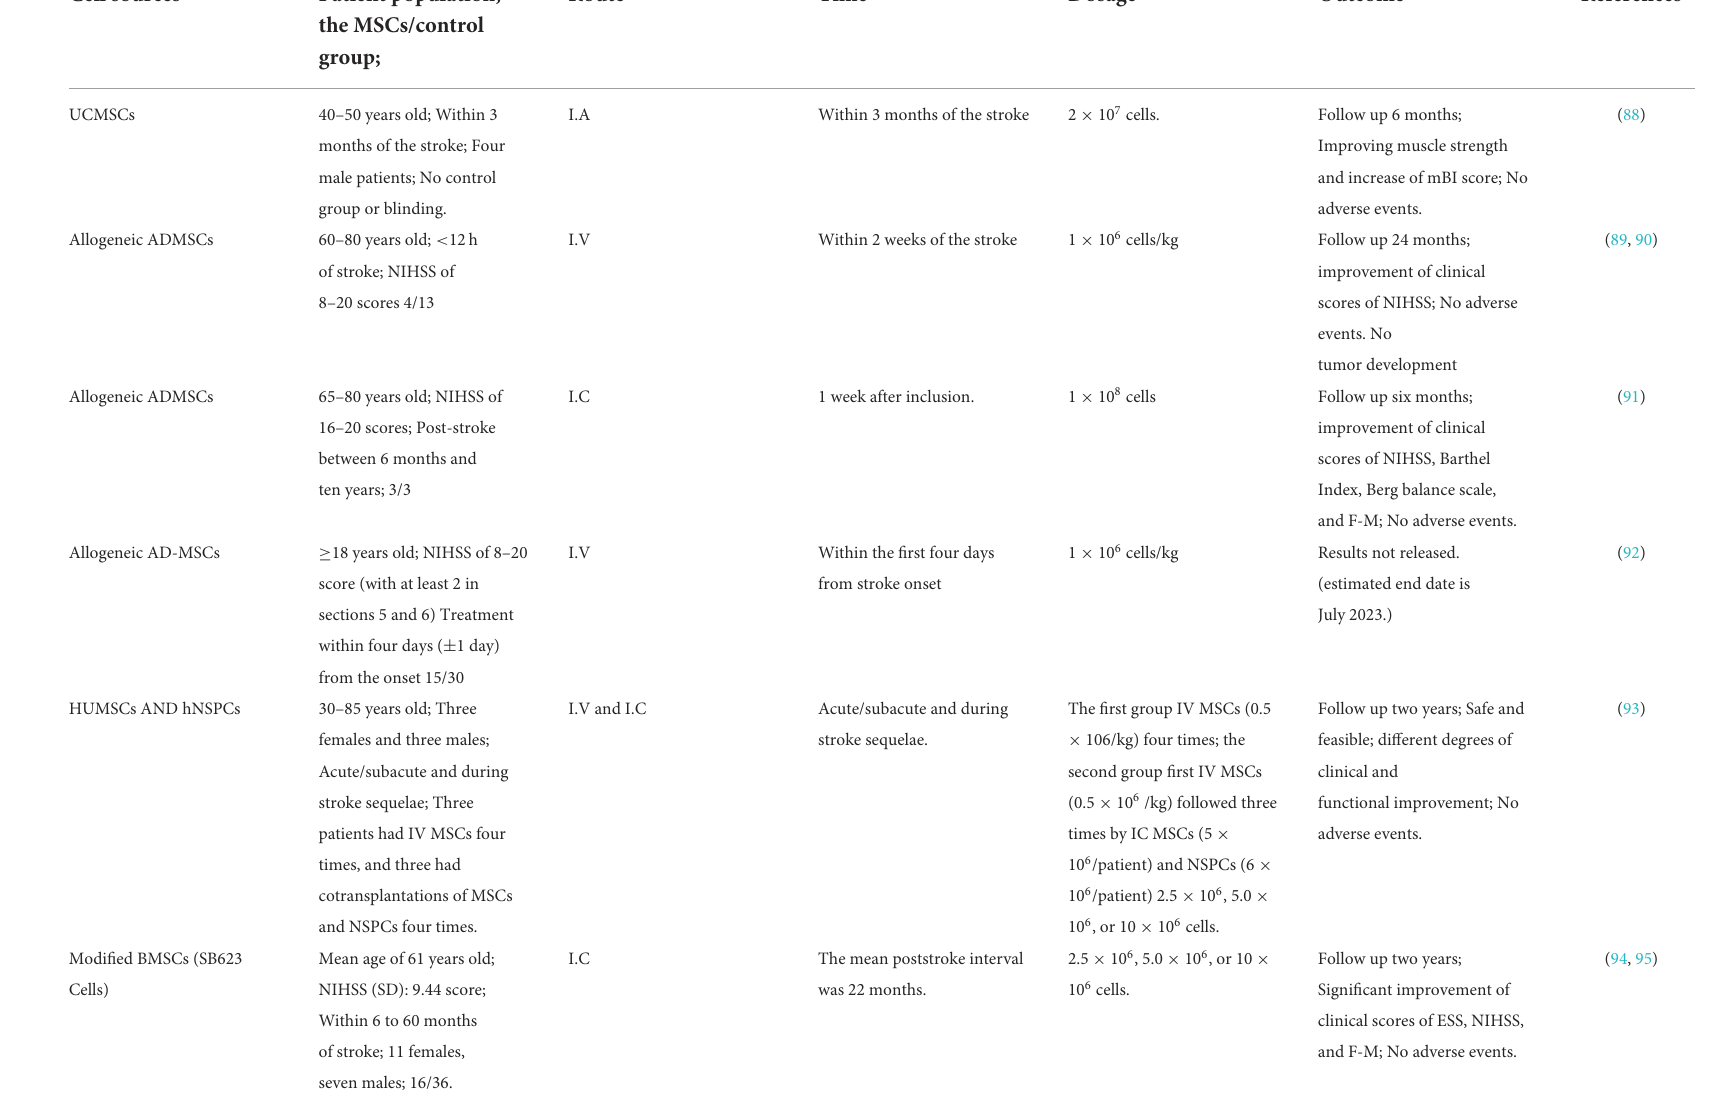
TABLE 3 Clinical studies of MSCs for the treatment of ischemic stroke for the past 10